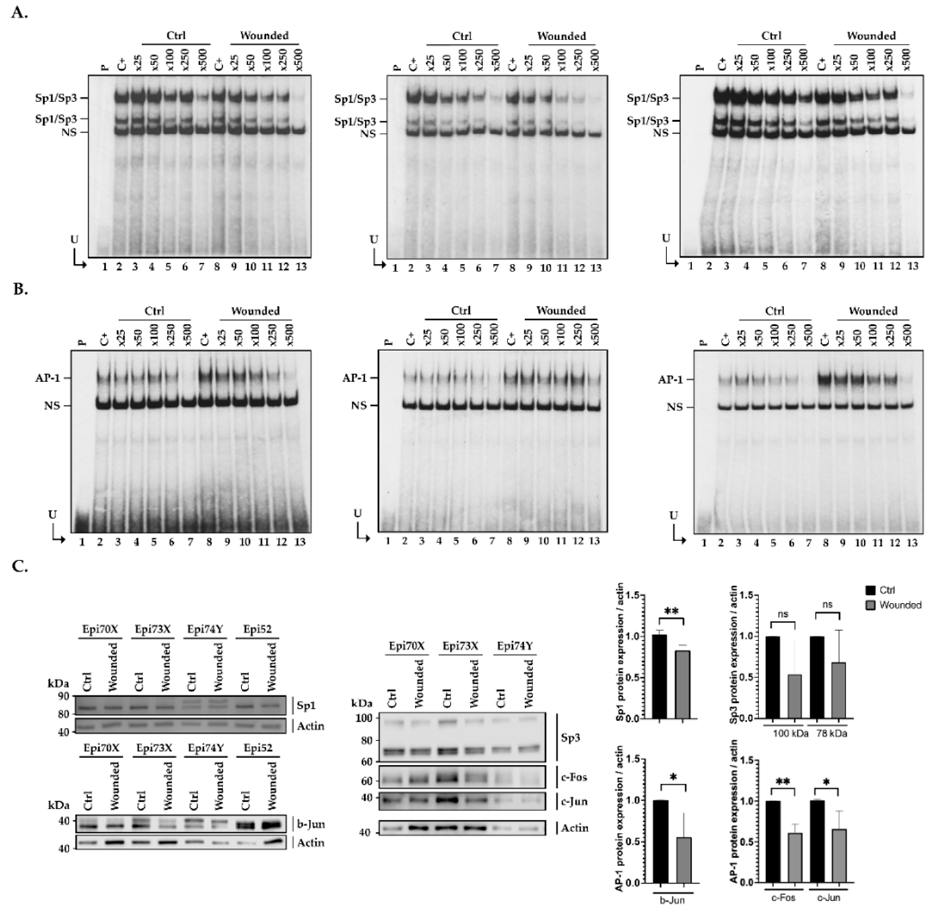
Figure 6. Sp1/3 and AP-1 binding after hCECs damages. ( A ) Nuclear protein (15 µ g) from control (Ctrl) and damaged (Wounded) hCECs (Epi 70x) were incubated with either the Sp1/Sp3 ( panel A ) or the AP-1 ( panel B ) labeled probe bearing the consensus sequence for the TFs Sp1/Sp3 and AP-1 TFs, respectively, either alone (C+) or in the presence of increasing molar excess (25 to 750-fold) of unlabeled competitor oligonucleotides. P: labeled probe without added proteins, U: free probe. Unlabeled competitor oligonucleotides used in the two left panels ( A , B ) bears the specific target site for the TFs Sp1/Sp3 ( A ) or AP-1 ( B ). Central panels are the same as in left panels except that DNA-protein complexes were competed with unlabeled CLU -203/-153 while the complexes in the right panel are competing with CLU Mutant 2. ( C ) Western blot (left and middle panels) and quantification analysis (right panel) of the AP-1 (c-Fos, c-Jun and b-Jun isoforms) and Sp1/Sp3 TFs expression in hCECs nuclear extract (Epi52, Epi70X, Epi73X, Epi 74Y). Actin expression was monitored as a normalization control. *: Values considered to be statistically significant from those obtained with the control (Ctrl) protein extract ( p value < 0.05). **: Values considered to be statistically significant from those obtained with the control (Ctrl) protein extract ( p value < 0.01). ns: Values considered to be statistically